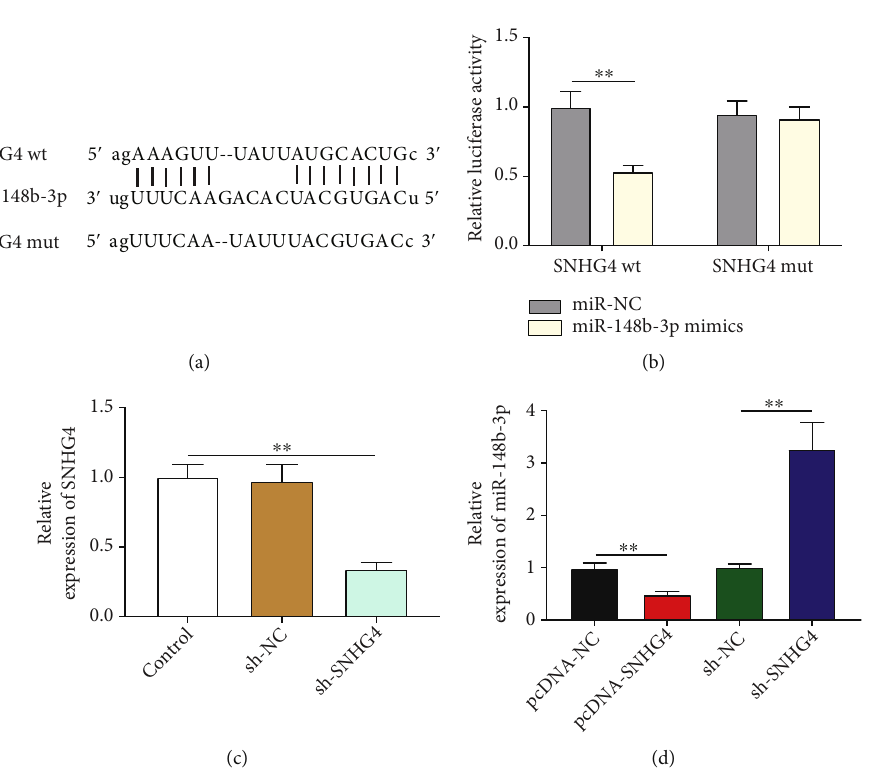
Figure 2: The target relationship between miR-148b-3p and SNHG4. (a) A binding site of SNHG4 and miR-148b-3p was predicted by StarBase. (b) DLR assay of the target relationship between miR-148b-3p and SNHG4. (c) The expression of SNHG4 in H9c2 cells transfected with sh-SNHG4/sh-NC was detected by qRT-PCR. (d) The expression of miR-148b-3p in H9c2 cells transfected with pcDNA-SNHG4/pcDNA-NC/sh-SNHG4/sh-NC was detected by qRT-PCR. ∗∗ P < 0 : 01